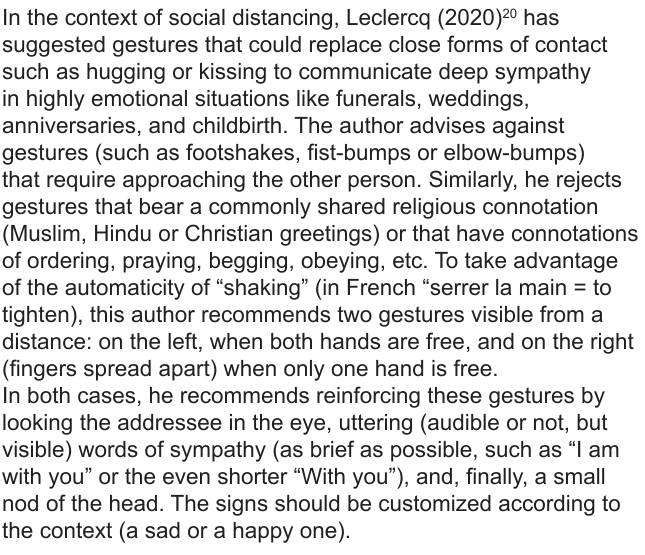
Figure 2. Social distancing: suggested gestures to replace close contact: “the long hand.”